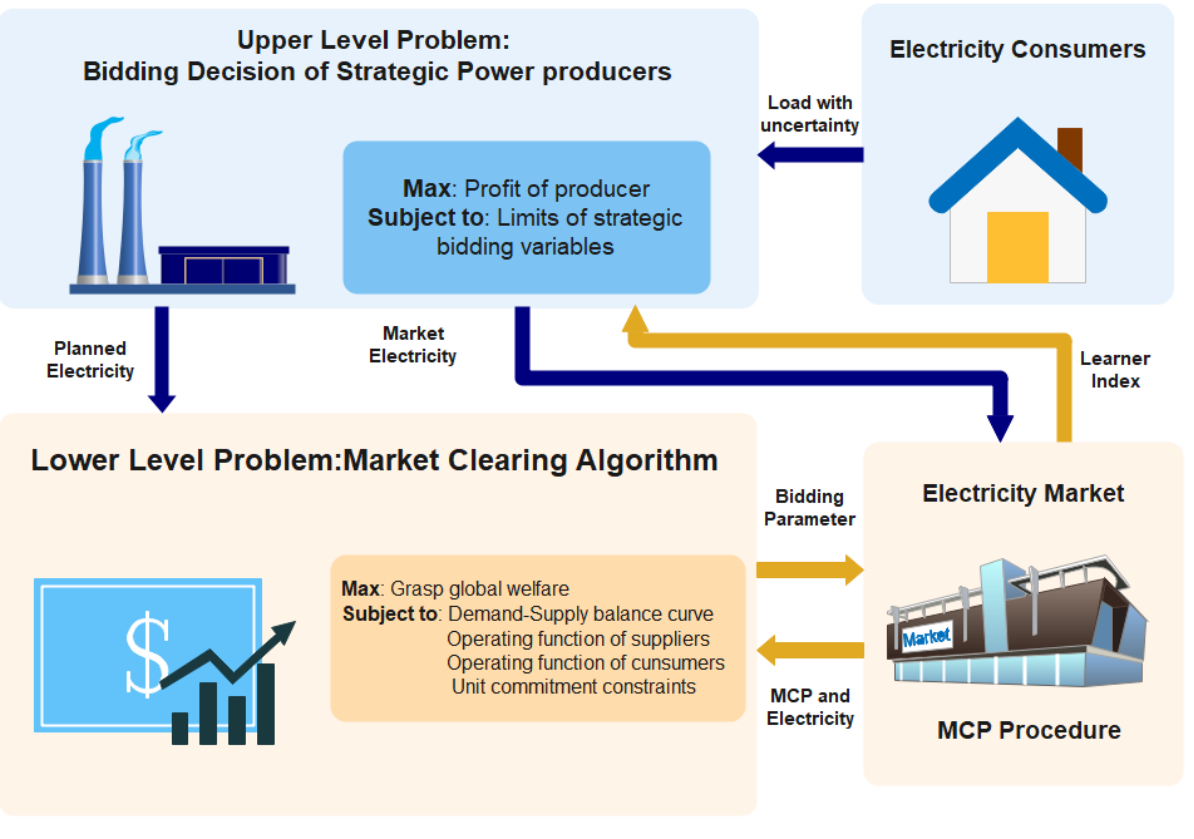
Figure 1. Electricity Market